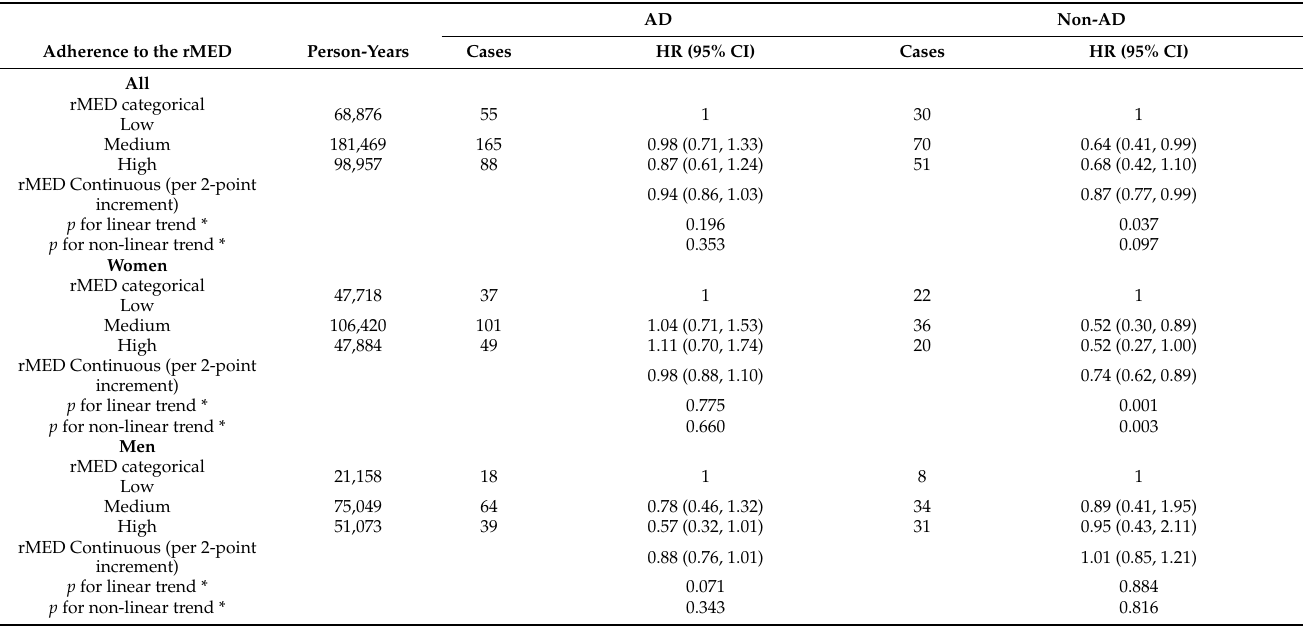
Table 3. Hazard ratio of dementia sub-types (Alzheimer’s and non-Alzheimer’s disease) by levels of Mediterranean Diet score (rMED) in participants from the EPIC-Spain Dementia Cohort study ( N = 16,160). AD Non-AD